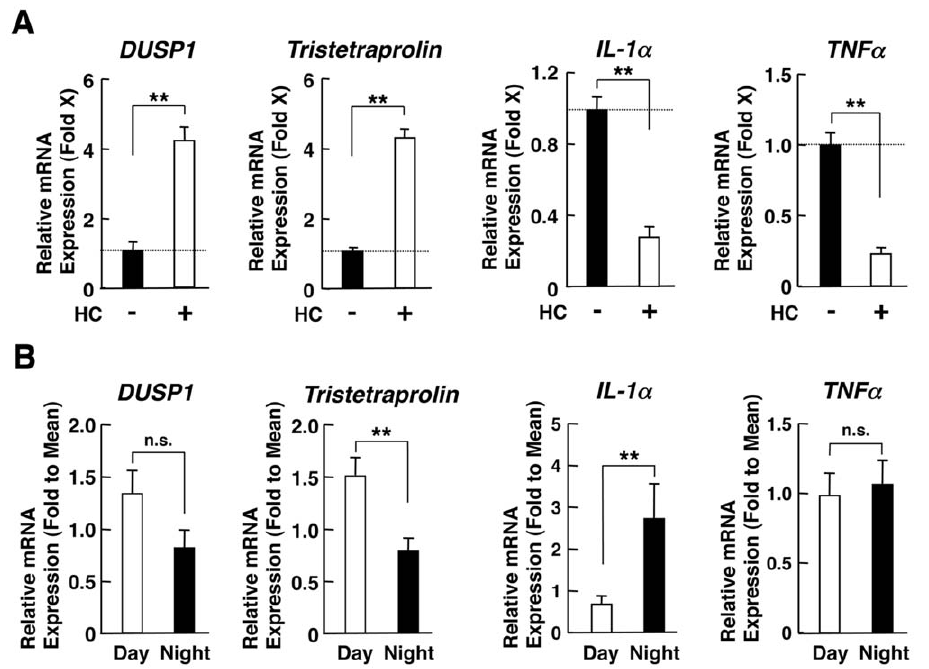
Figure 4. Response of glucocorticoid-responsive gene mRNA expressions to hydrocortisone in EBV-transformed peripheral lymphocytes and their daily changes in PBMCs. A: The effect of hydrocortisone on the expression of the mRNAs of known glucocorticoid- responsive genes in EBV-transformed peripheral lymphocytes. Samples obtained as in Figure 3 were used for the evaluation of mRNA expression of the known glucocorticoid-responsive genes indicated. DUSP1 and tristetraprolin are the genes known to be up-regulated by glucocorticoids, while IL- 1 a and TNF a represent those known to be down-regulated. The measurements were performed in triplicate. Bars represent the mean 6 S.E. values of hydrocortisone (HC)-induced fold mRNA expression of indicated genes. **: P , 0.01, compared to the conditions indicated (m=3). B: mRNA expression of the known glucocorticoid-responsive genes in the morning and in the evening. Relative mRNA expression of DUSP1, tristetraprolin, IL-1 a and TNF a at 8 am (Day) and at 8 pm (Night) in PMBCs obtained from 10 healthy subjects is shown. The measurements were performed in duplicate for each subject. Bars represent mean 6 S.E. values of relative mRNA expression of the genes indicated. **: P , 0.01, n.s.: not significant, compared to the conditions indicated (n=10,